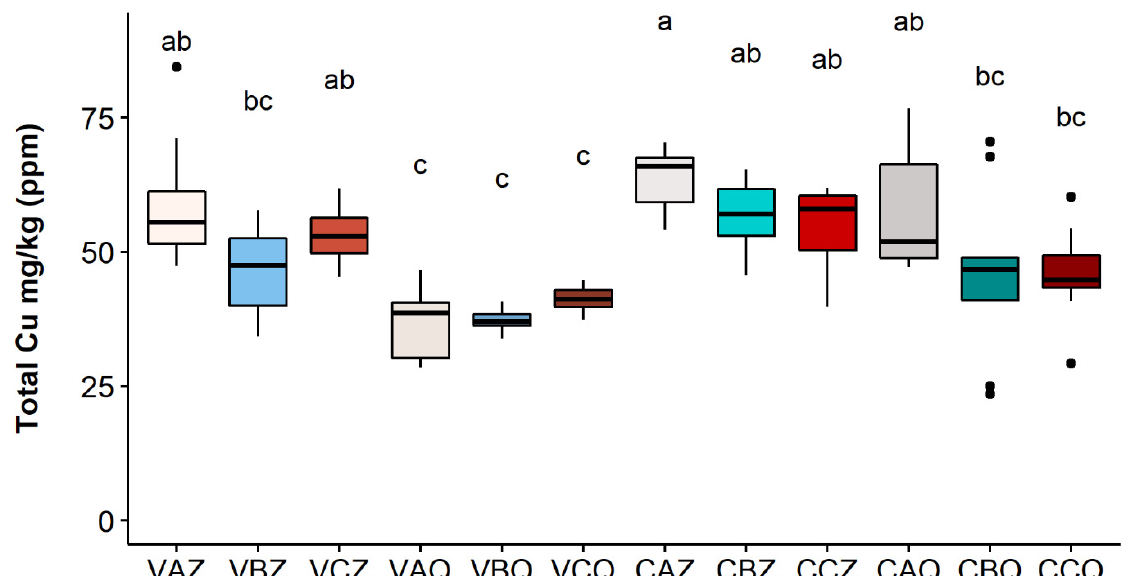
Figure 3. Total Cu concentration in each sample in 2020. Lower case letters refer to Dunn’s multiple comparisons (Benjamini–Hochberg p -value adjustment, α -level = 0.05). Code legend: the first letter refers to the vineyard; (C) Castelplanio, (V) Varano. The second letter refers to the thesis: (A) Cu treatments, (B) Alternate treatments with Cu and chitosan, and (C) Chitosan treatments. The third letter refers to the depth: (Z) 0–20 cm, (Q) 20–40 cm.